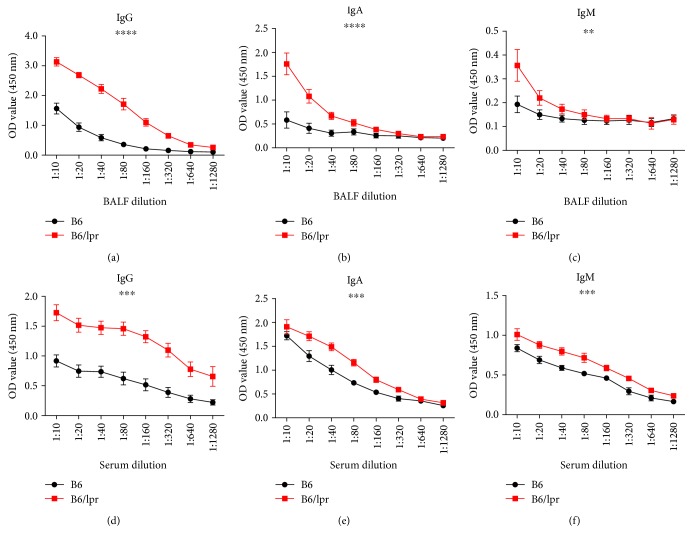
Bacteria-specific antibodies were significantly increased in the infected lupus-prone mice. Ten days after infection, B6 and B6/lpr mice were sacrificed. BALF and sera were collected. Hi-specific IgG (a, d), IgA (b, e), and IgM (c, f) were determined by ELISA. Data were expressed as means ± SEM and analysed by one-way ANOVA. n = 3 mice for each treatment group. ∗∗p < 0.01, ∗∗∗p < 0.001, and ∗∗∗∗p < 0.0001.